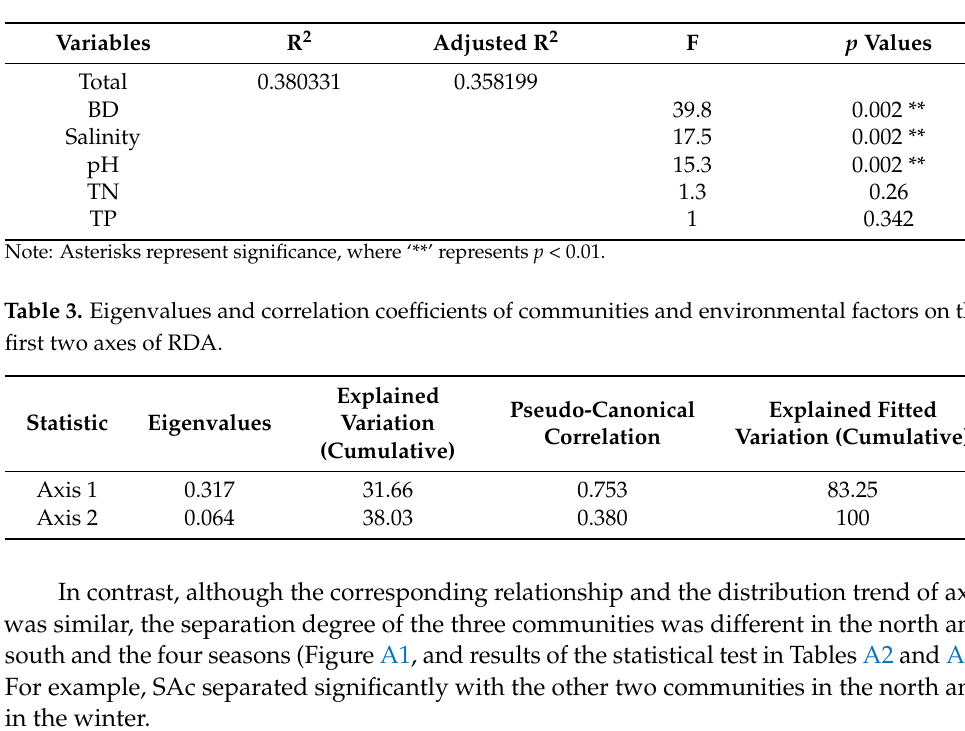
Table 2. Statistical results based on ANOVA of communities and environmental factors in RDA.